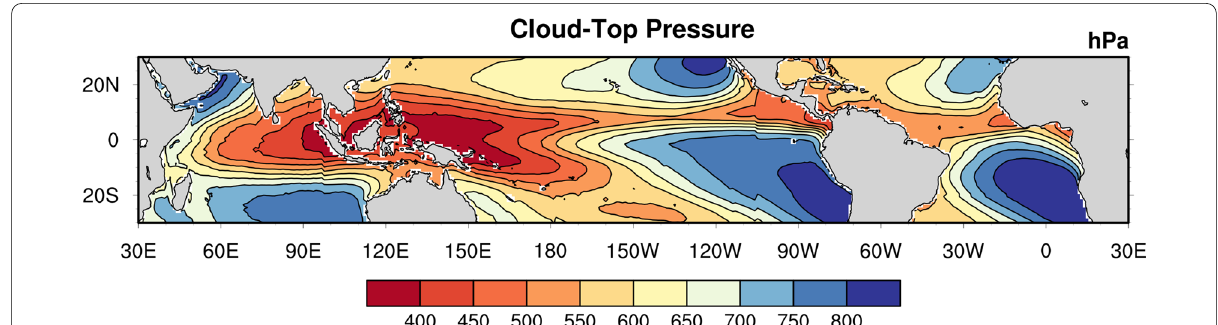
Fig. 5 The spatial pattern of cloud‑top pressure derived from CERES‑SYN averaged over the period 2000/03–2014/12. The color (or contour) interval is 50 hPa